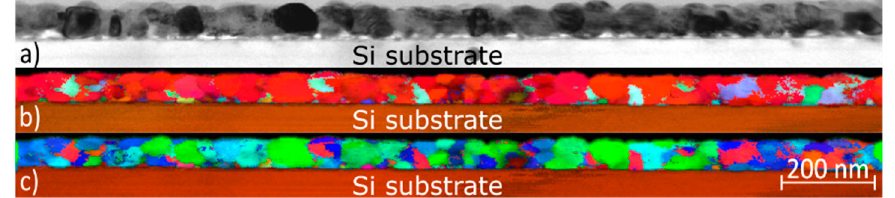
Figure 6. Transmission electron microscopy automated crystalline orientation and phase maps recorded in the basal plane of the seed layer preheated at 400 °C and annealed in the air at 600 °C ( a ) showing a strong c-axis texture ( b ) and a random in-plane orientation ( c ).